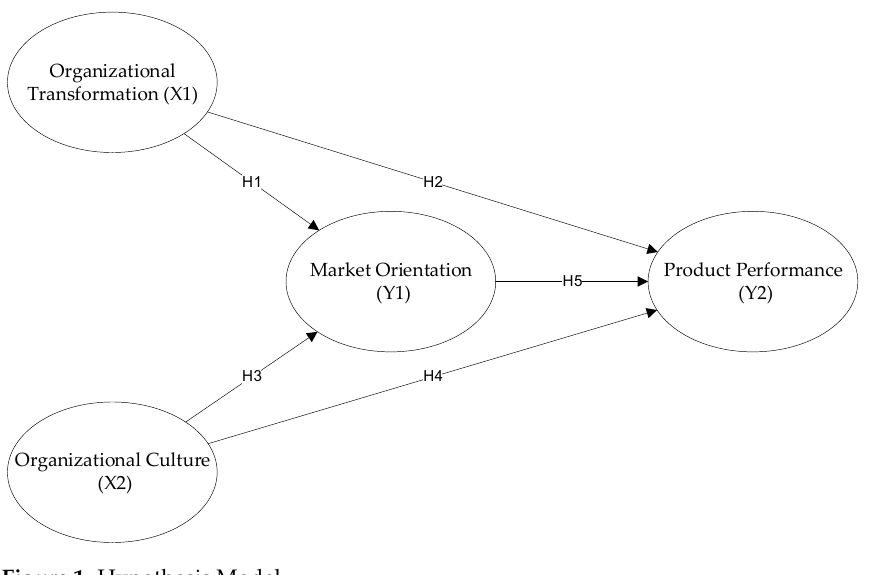
Figure 1. Hypothesis Model.